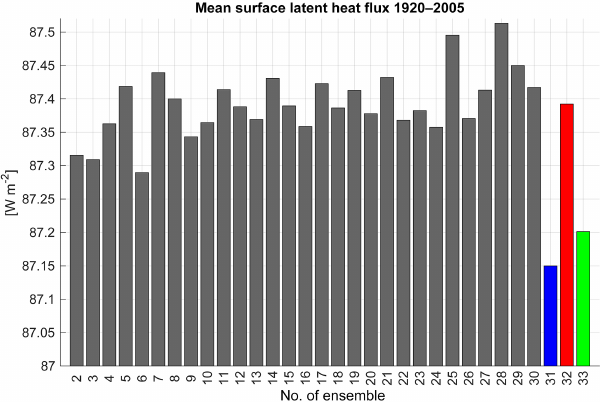
Figure 6. Mean surface latent heat flux (LHFLX) from 1920 to 2005 for CESM-LE members 2–30 and new members 31–33. Note that members 31 and 33 have been subjected to lossy compression.